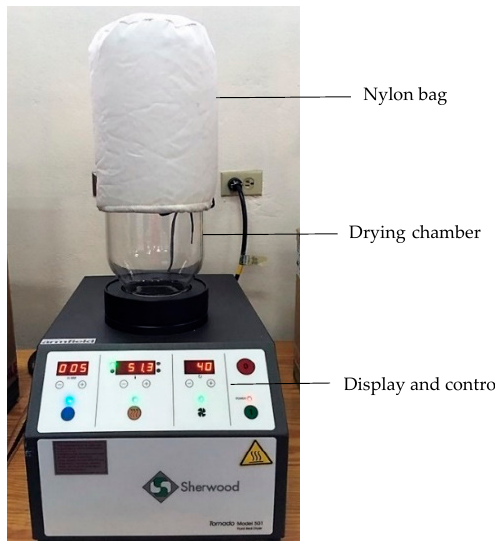
Figure 1. Sherwood Scientific Tornado M501 Fluid Bed Dryer.